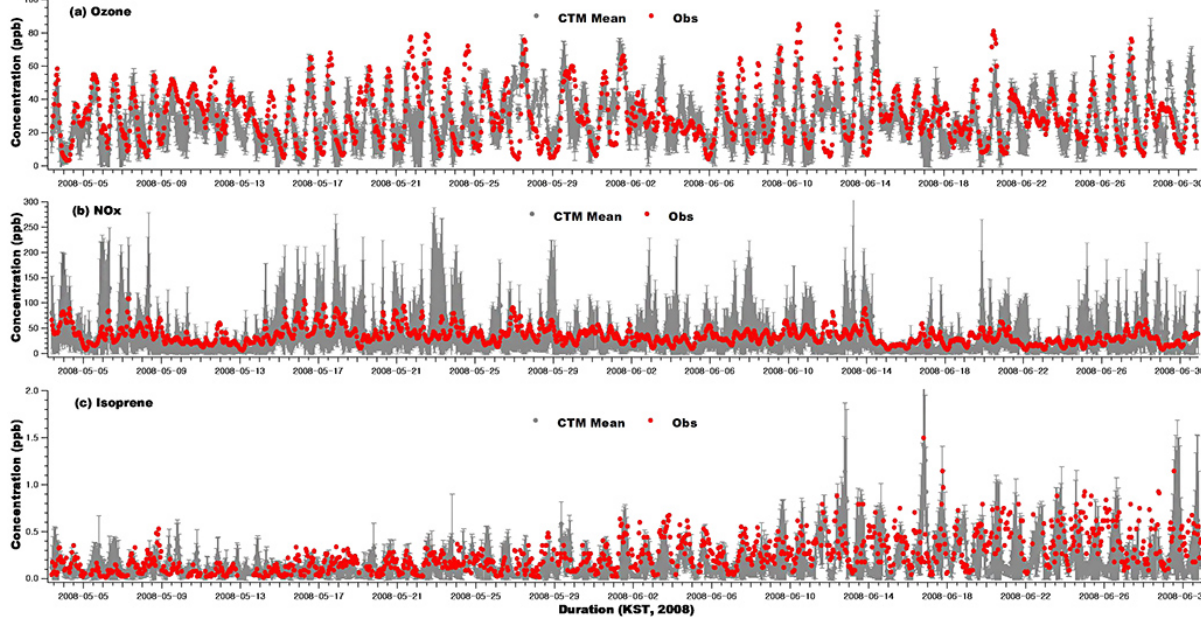
Figure 3. Evaluation of CMAQ results for hourly O 3 concentrations. Note that “CTM Mean” represents the average of the CMAQ predicted O 3 concentrations from the three different BVOC scenarios, and “Obs” represents the average of measured O 3 concentrations at monitoring stations across the domain. Table 3. Performance statistics for CMAQ O 3 with the three different BVOC emission scenarios against the measured O 3 concentrations. Mean (ppb) MB (ppb) NMB (%) NME (%) Correlation coeff. Obs. KORPFT